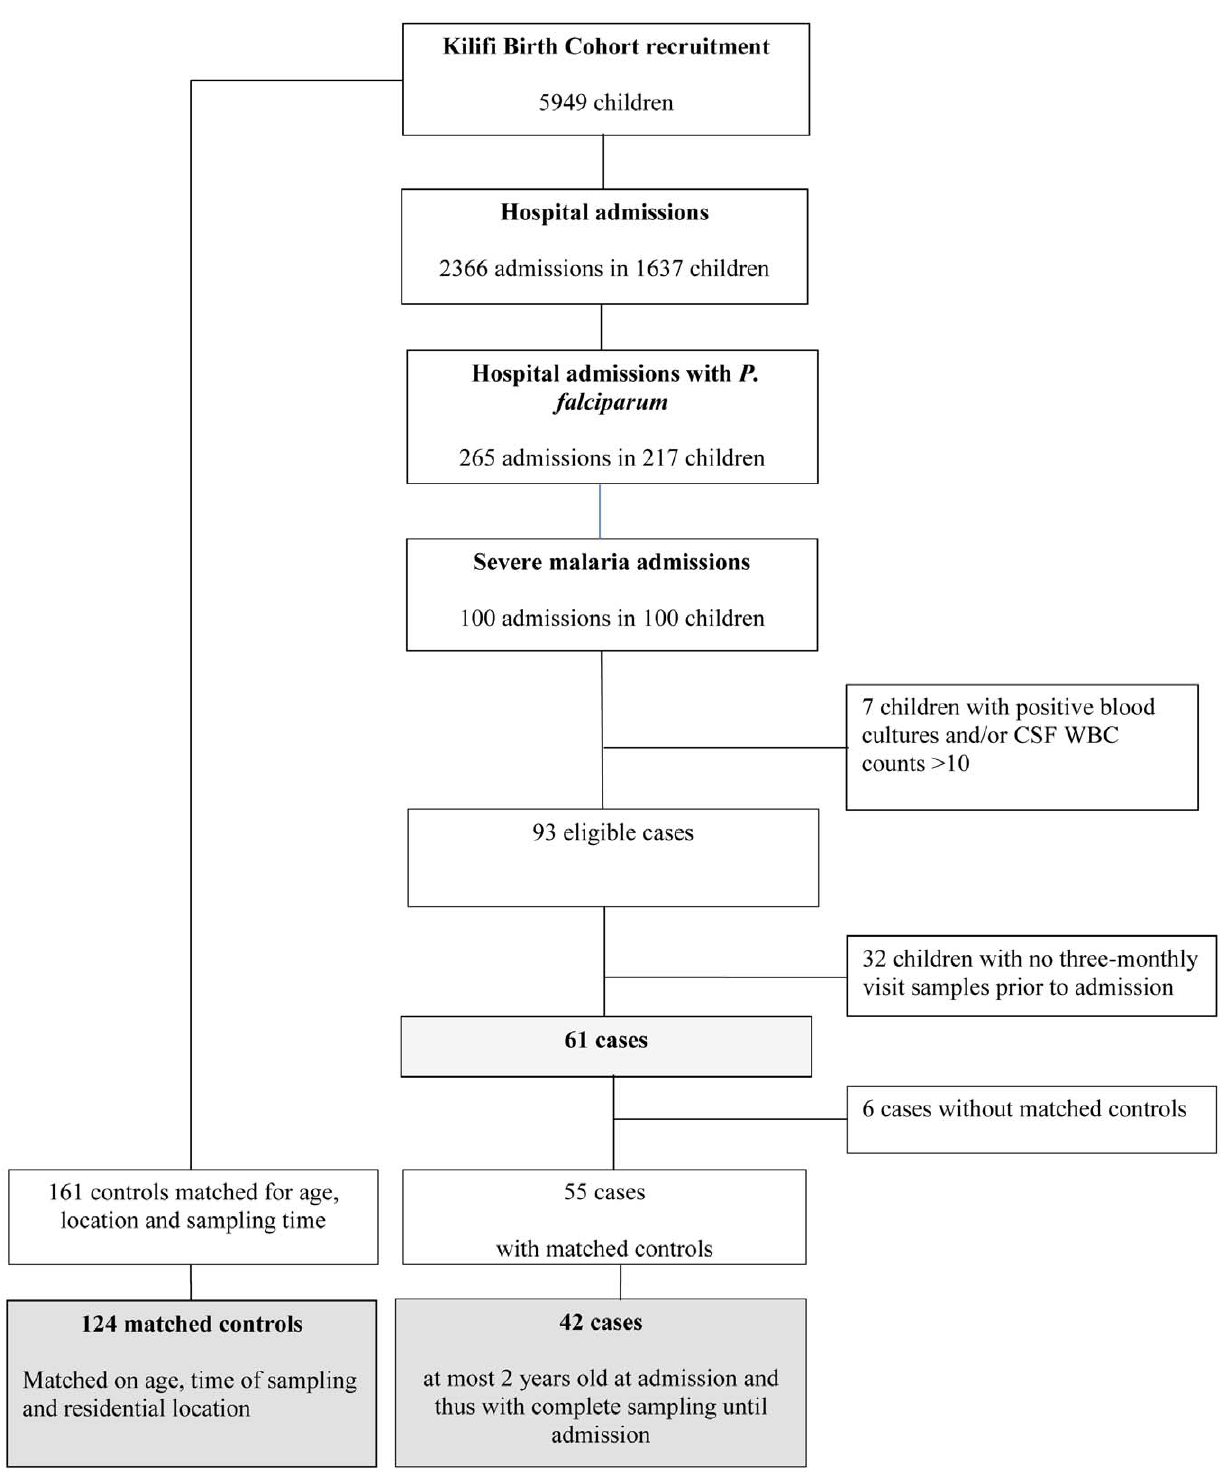
Figure 1. Matched case-control study profile.